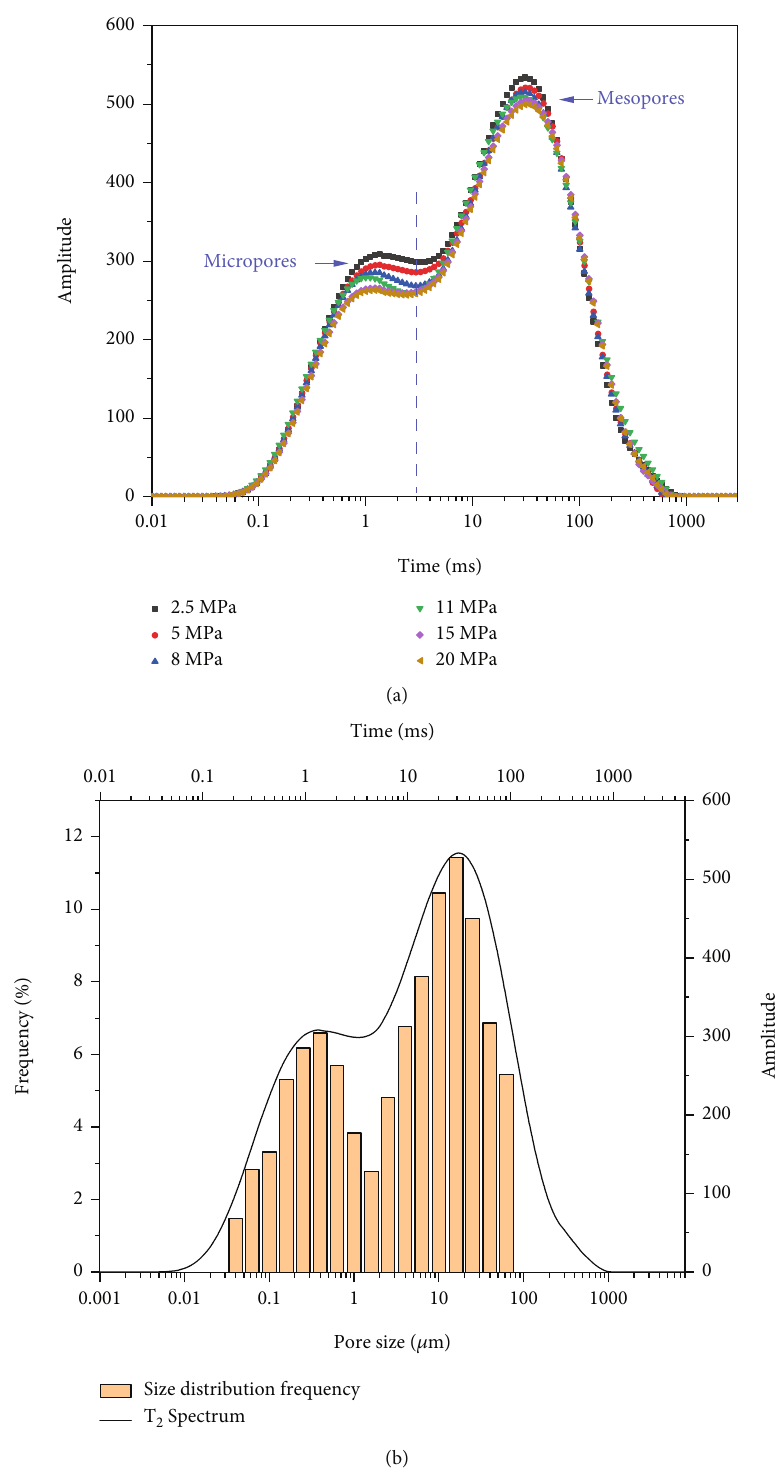
ff erent net stress, (b) the coupling relation between T